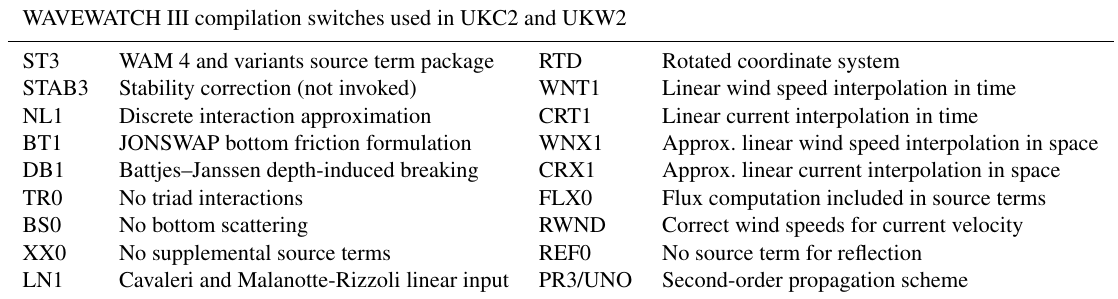
Table C7. Summary of WAVEWATCH III compile switches used in the UKC2 system. WAVEWATCH III compilation switches used in UKC2 and